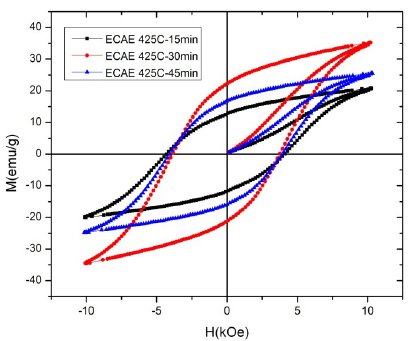
Figure 4. Variation in magnetic properties of three billets extruded from gas-atomized particles milled for 20 h in a large attritor extruded at 425 °C for 15, 30 and 45 min.